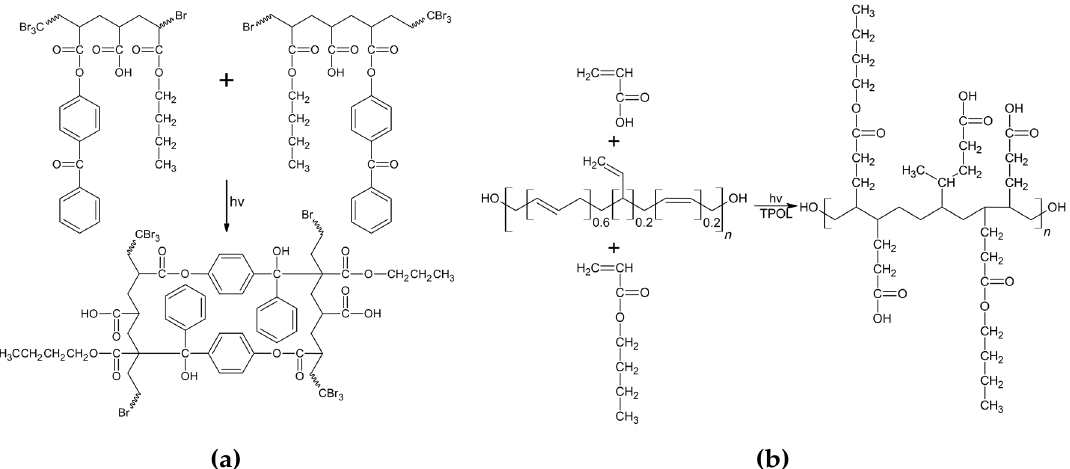
Figure 4. Photocrosslinking in pressure-sensitive adhesives (PSAs): ( a ) via copolymerizable photoinitiator ABP (hydrogen abstractor) and ( b ) via HTB and unreacted monomers.